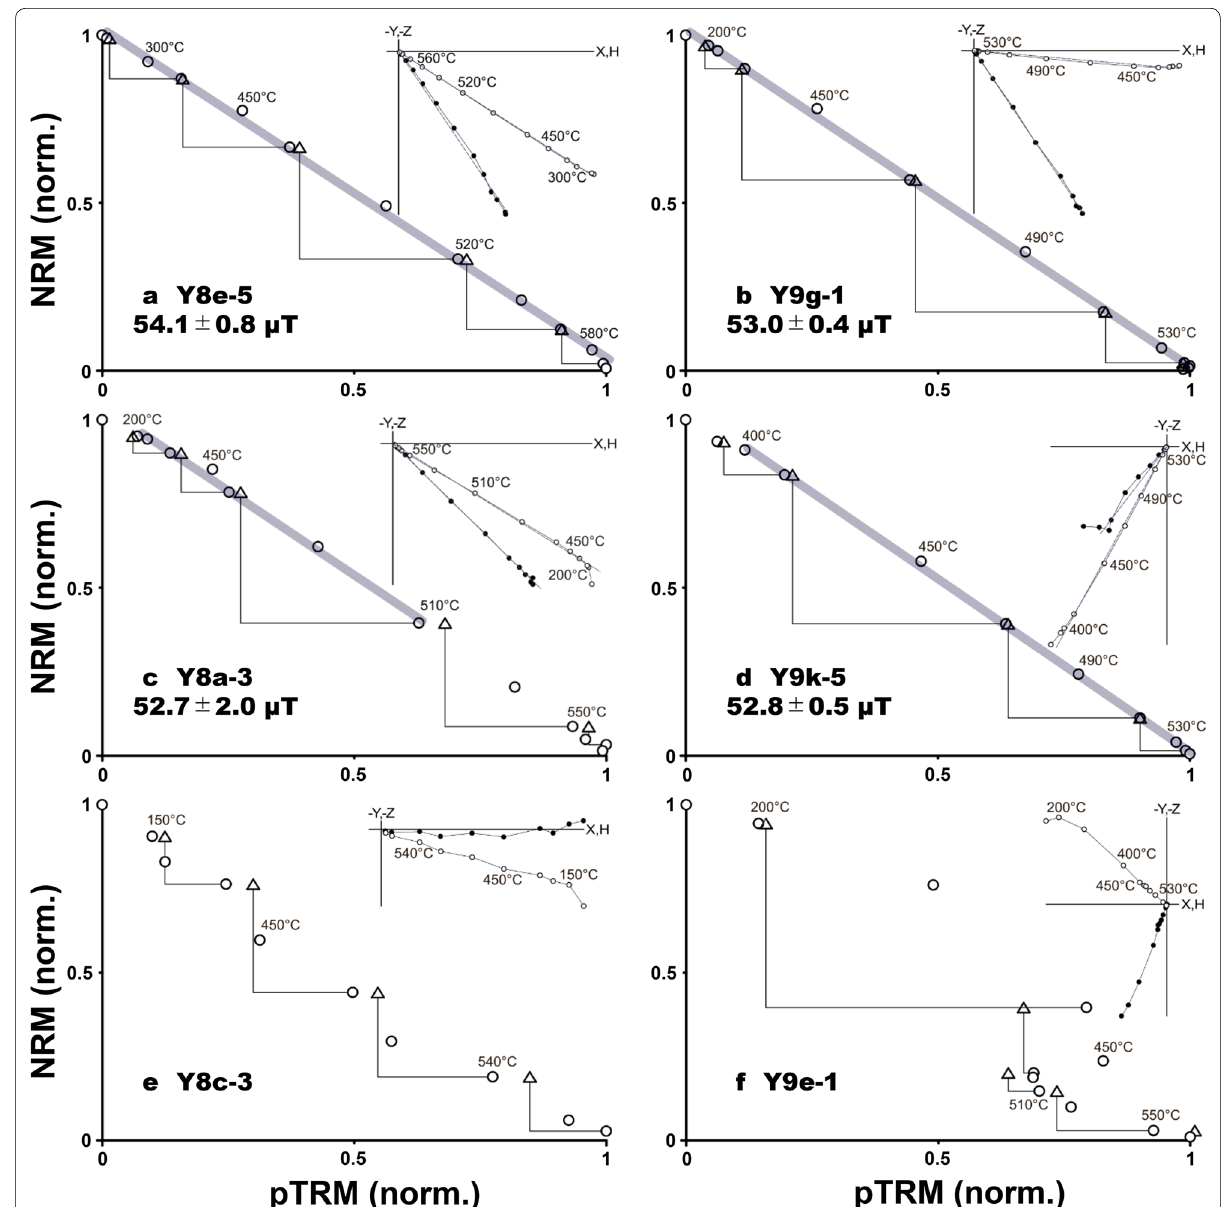
Fig. 5 Typical Arai plots of accepted ( a – d ) and rejected ( e , f ) specimens obtained from IZZI-Thellier experiments. Circles represent the normalized NRM vs. pTRM data with best-fit lines marked in gray. pTRM checks are shown as triangles. Zijderveld plots of the experiments are also shown as inset figures. Paleointensity analysis was conducted using ThellierTool (Leonhardt et al.